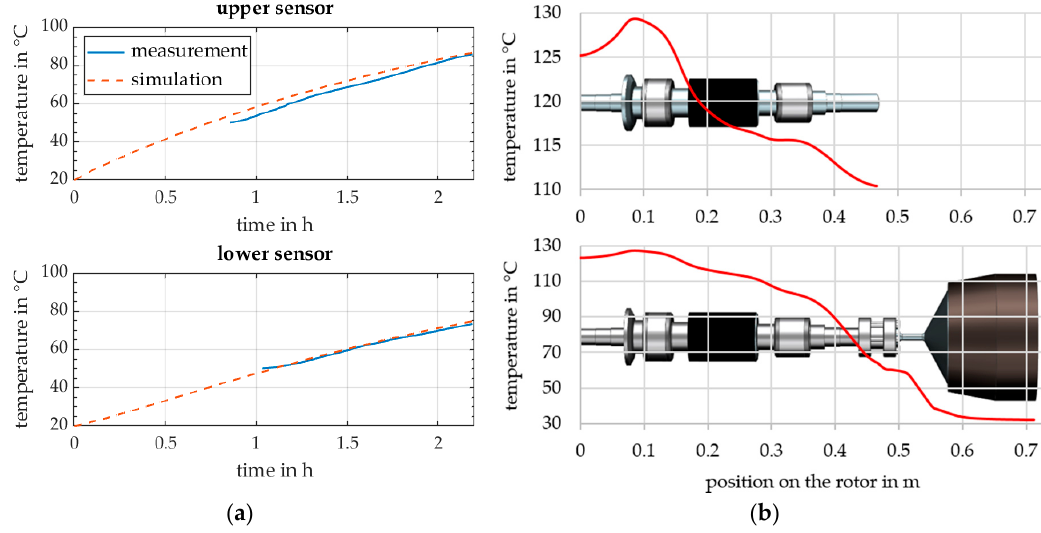
Figure 11. ( a ) Simulated and measured rotor temperatures with a reduced bias current of 4 A in both AMBs without the specimen during cycling; ( b ) Steady state rotor temperature with a reduced bias current of 4 A in both AMBs with and without the